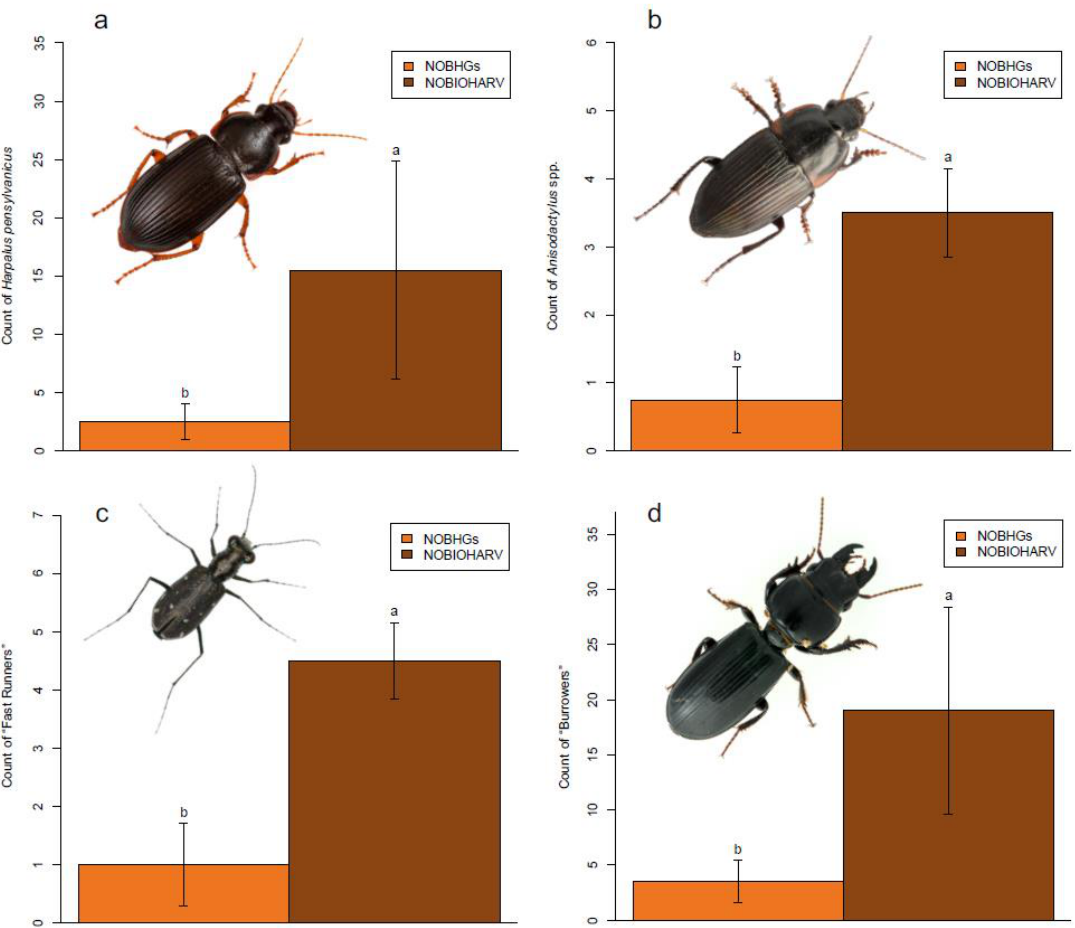
Figure 3. Response of ( a ) Harpalus pensylvanicus (Photo credit: Salvador Vintanza), ( b ) Anisodactylus spp.- A. haplomus pictured (Photo credit: Iustin Cret), ( c ) the “Fast Runner” functional trait- Cicindelidia punctulatapunctulata pictured(Photocredit: ChrisWirth), and( d )the“Burrower”functionaltrait– Scarites subterraneus pictured (Photo credit: John and Kendra Abbot / Abbott Nature Photography) to no retention of harvest residues (NOBHGs) and complete retention of harvest residues (NOBIOHARV) treatments in clear-cut stands, North Carolina, 2013. Di ff erent letters indicate significantly di ff erent pairwise comparisons of treatment means. We set α = 0.05. See Supplementary Materials for comparisons of all harvest reside retention treatment